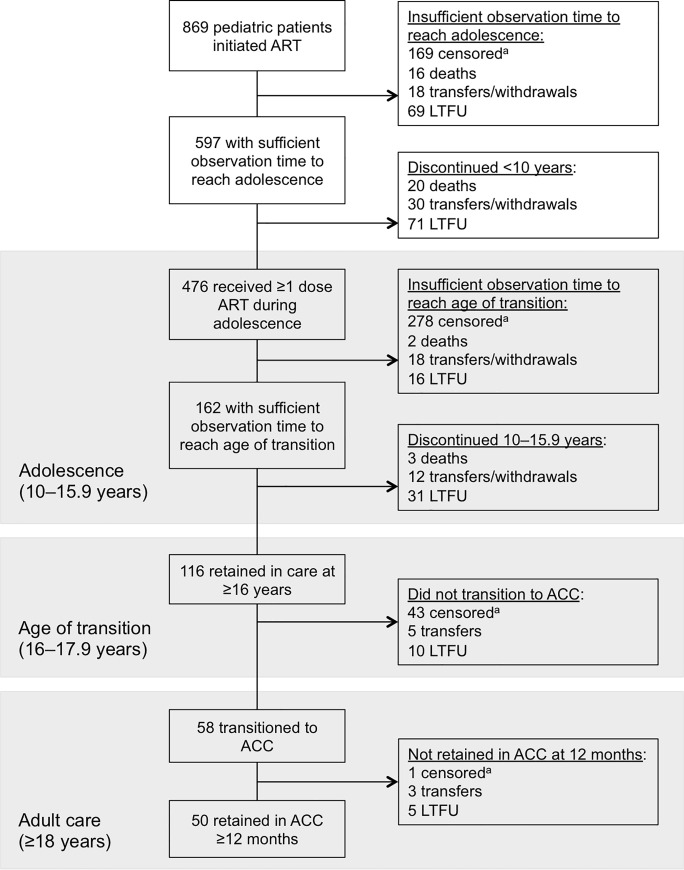
Flow chart of patients.ART, antiretroviral therapy; LTFU, loss to follow-up; JUTH, Jos University Teaching Hospital; CCC, child-centered care; ACC, adult-centered care. aCensored due to reaching end of study period.